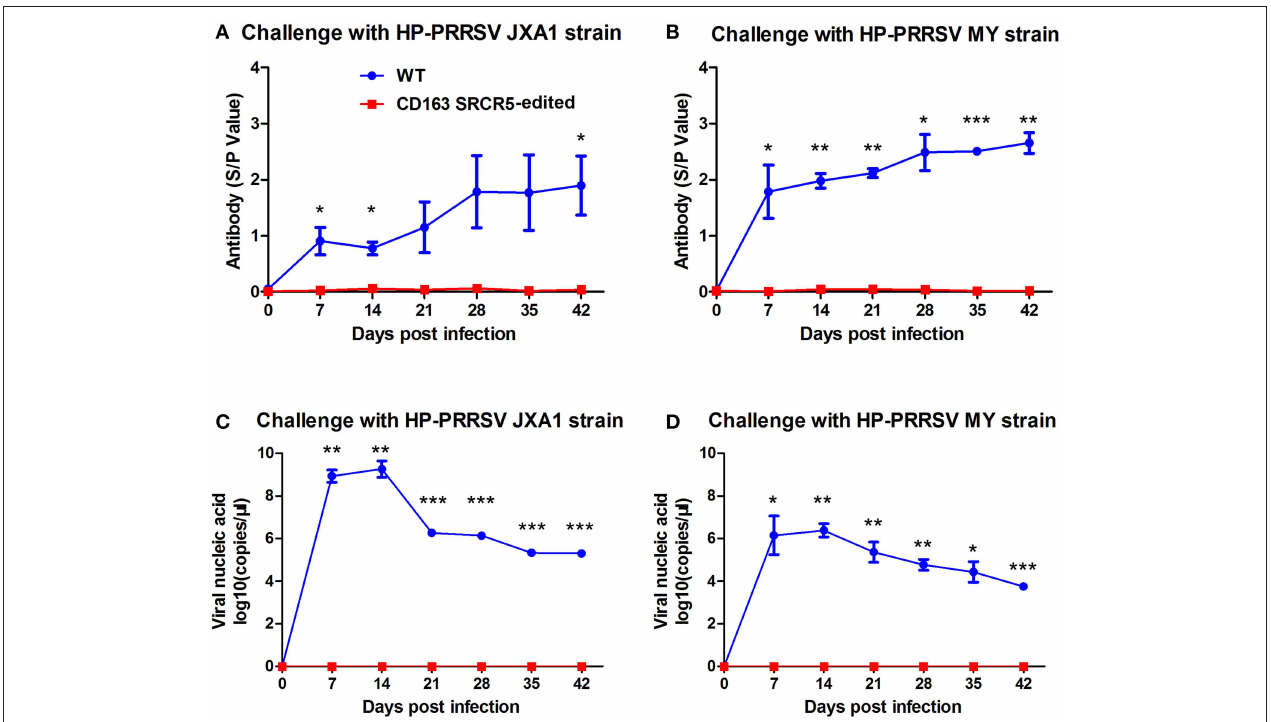
FIGURE 6 | Viremia and anti-PRRSV antibodies are not present in CD163 SRCR5-edited animals. (A,B) Blood samples were collected to detect anti-PRRSV antibody titers on days 0, 7, 14, 21, 28, 35, and 42 post PRRSV JXA1 (A) and MY (B) challenge in CD163 SRCR5-edited animals and WT controls. The absorbance was detected at a wavelength of 570nm. Antibody titers are represented as sample absorbance/positive absorbance (S/P). (C,D) Viral nucleic acid copy numbers in blood samples were measured on the designated days post JXA1 (C) and MY (D) inoculation of CD163 SRCR5-edited and WT animals. The red line represents CD163 SRCR5-edited pigs and the blue line represents WT controls. Data are representative of the results of three independent experiments (means ± SE). Significance is indicated as follows: * P < 0.05, ** P < 0.01, *** P <